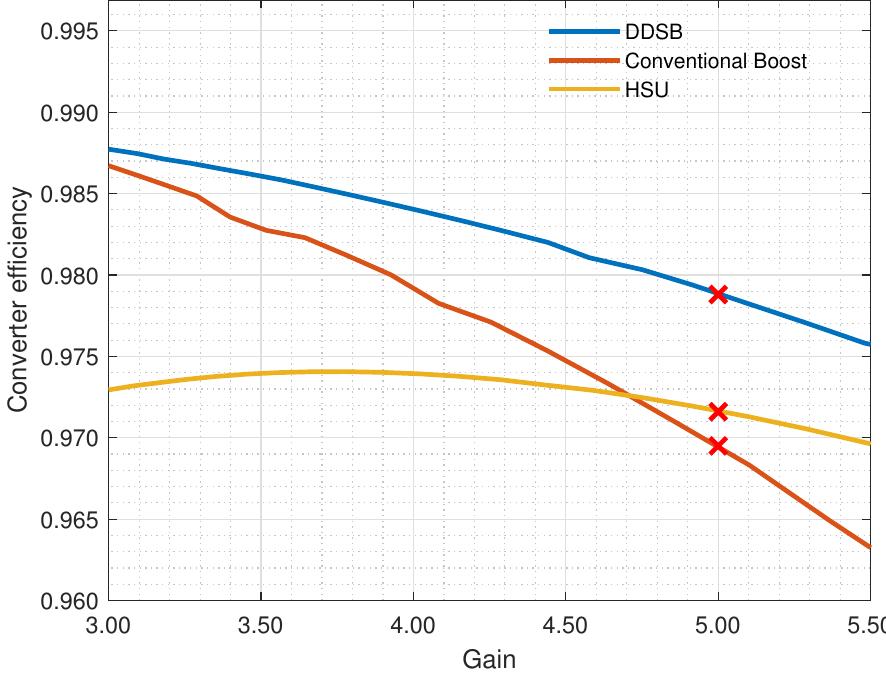
Figure 11. Efficiency of the conventional boost and HSU vs. DDSB power converters, taking into account a fixed load.